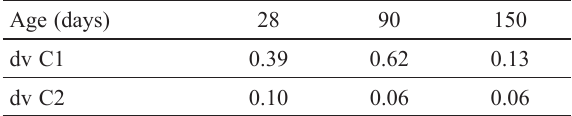
Table 6. Standard deviation of air permeability